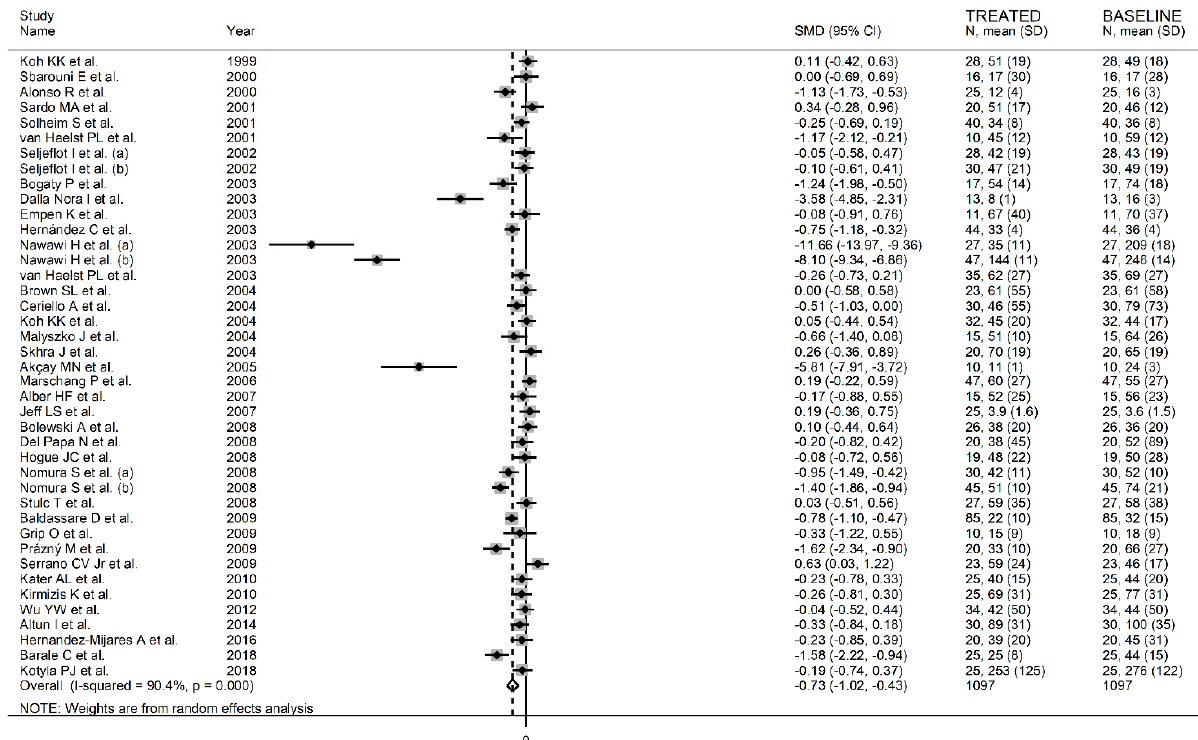
Figure 11. Forest plot of E-Selectin concentrations before and after statin treatment.